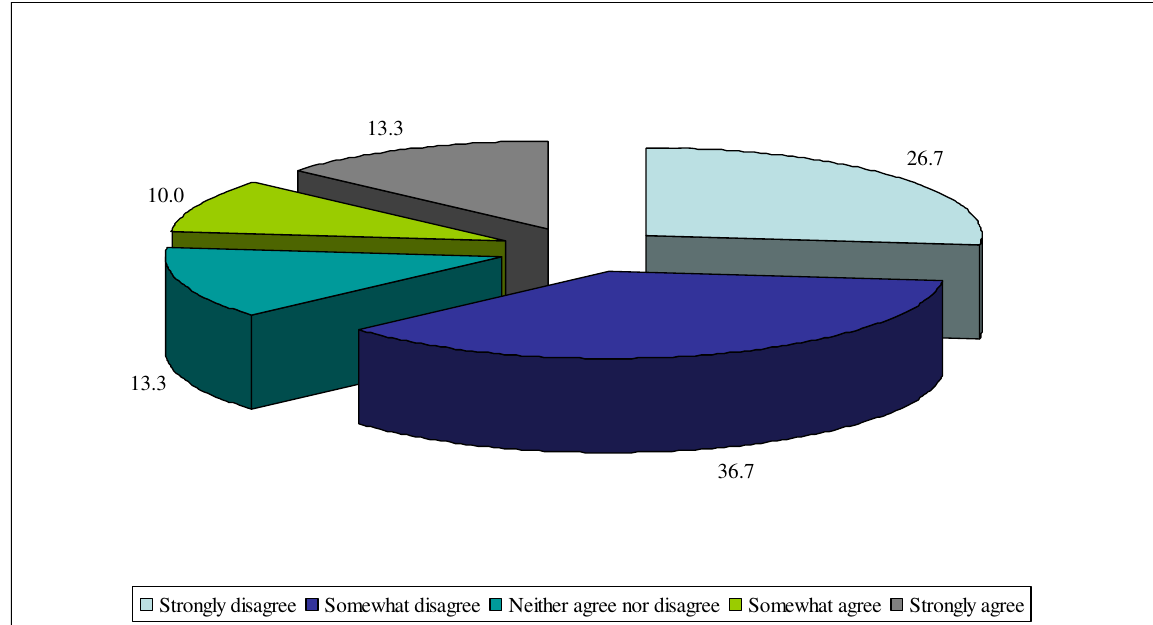
Fig. 2. NCA’s effectiveness in curbing reckless lending practices